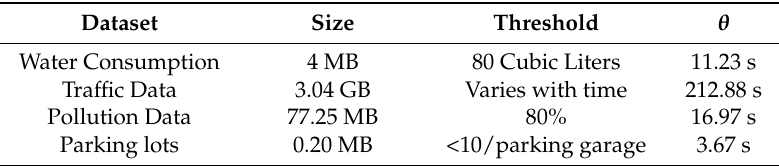
Table 3. Event generation performance and threshold limits.